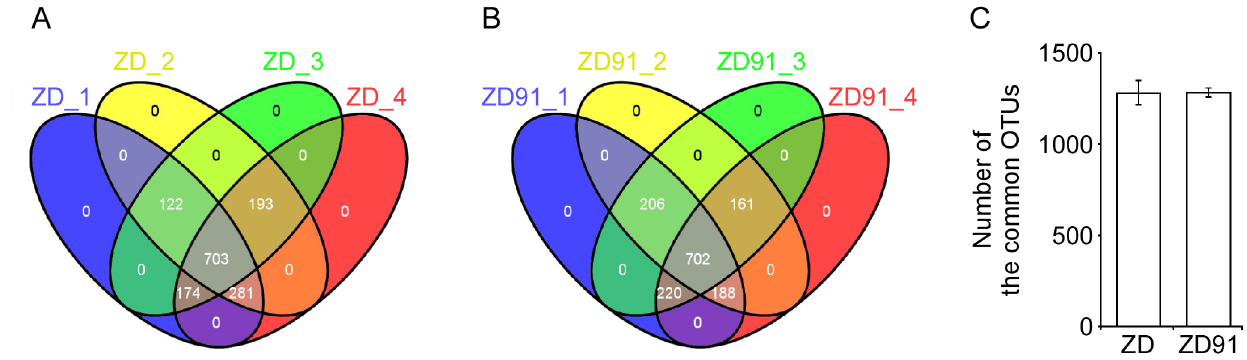
Figure 4. Common OTUs recovered from soil. (A) Venn diagram showing variable overlap between four replicates of ZD. (B) Venn diagram showing variable overlap between four replicates of ZD91. (C) Number of the common OTUs between ZD and ZD91.